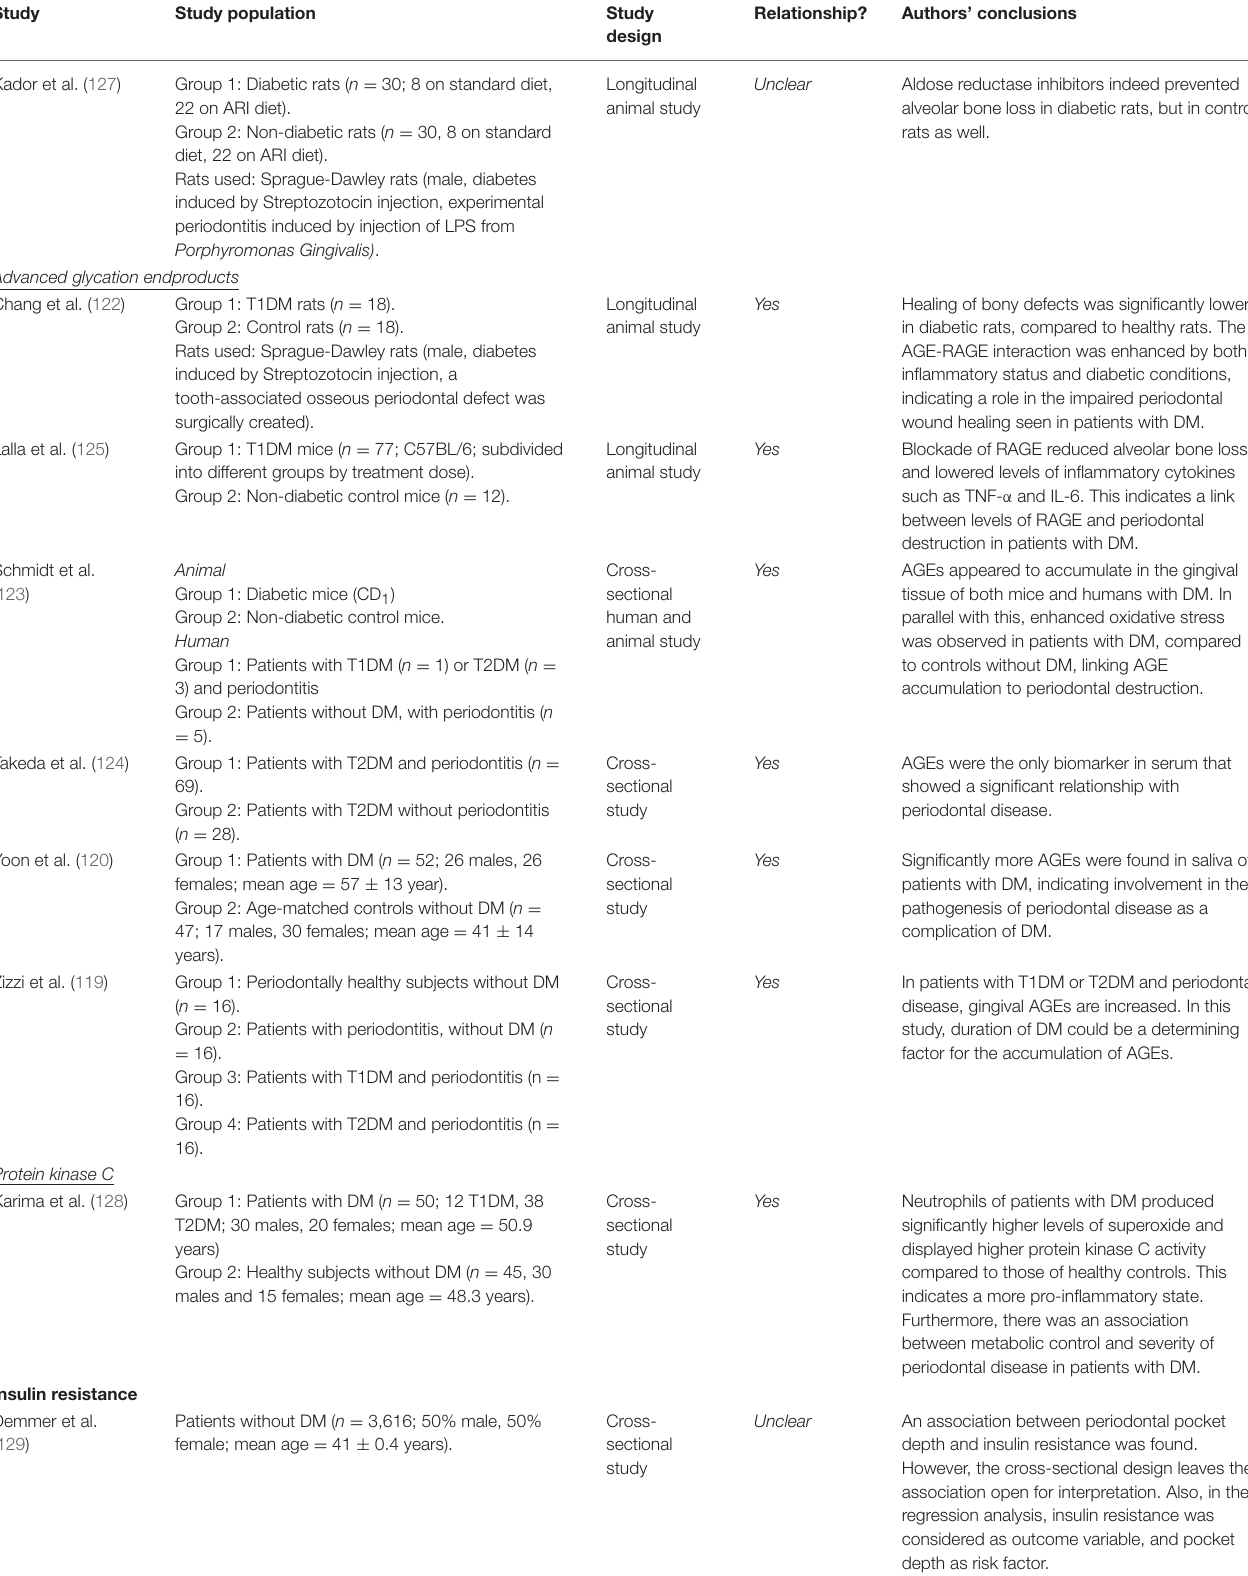
Unclear Aldose reductase inhibitors indeed prevented Longitudinal animal study alveolar bone loss in diabetic rats, but in control rats as well.